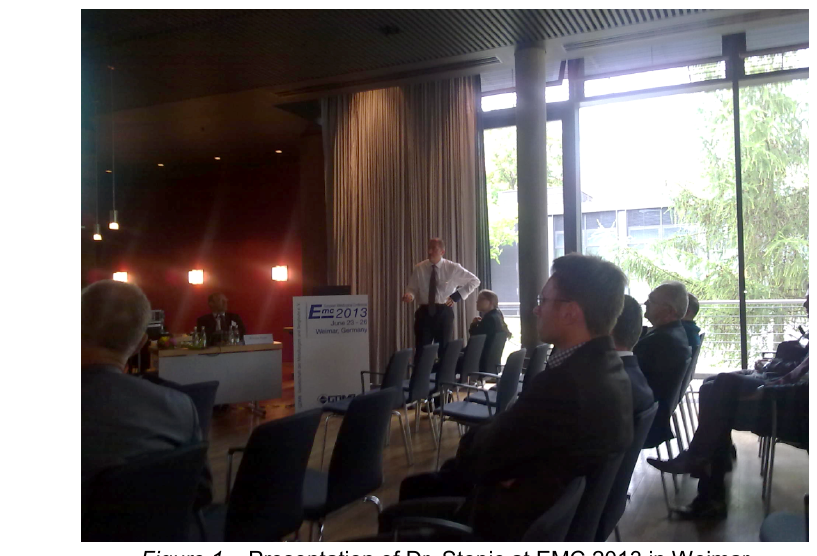
Figure 1 – Presentation of Dr. Stopic at EMC 2013 in Weimar Slika 1 – Prezentacija dr Stopi ć a na EMC 2013 u